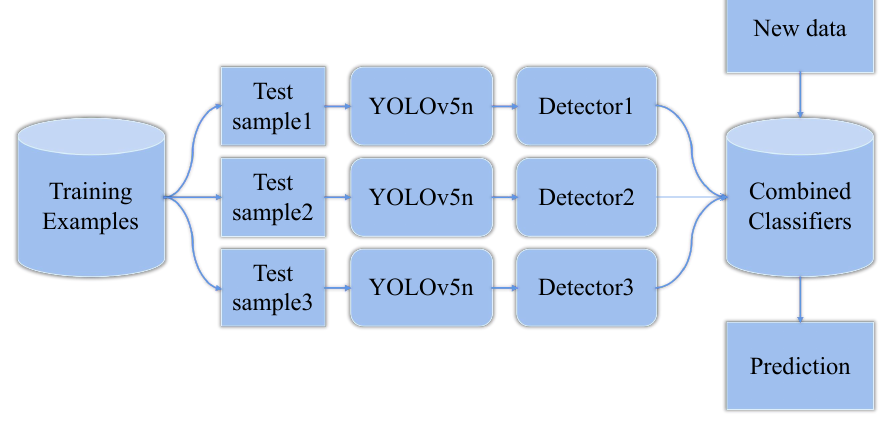
Figure 6. Structure of Ensemble